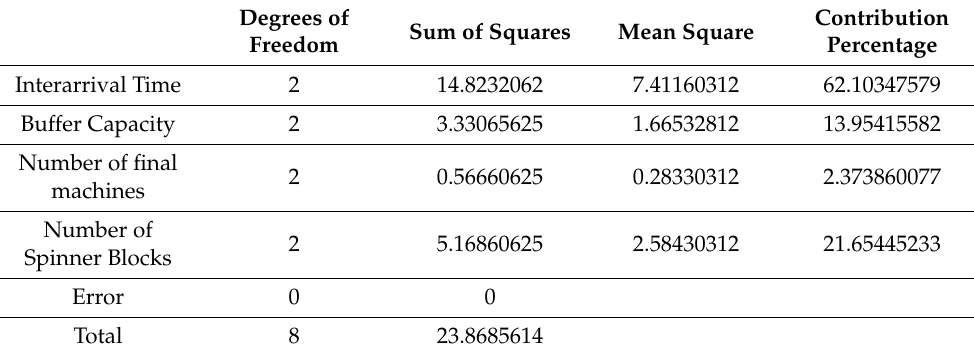
Table 10. ANOVA table excluding error.